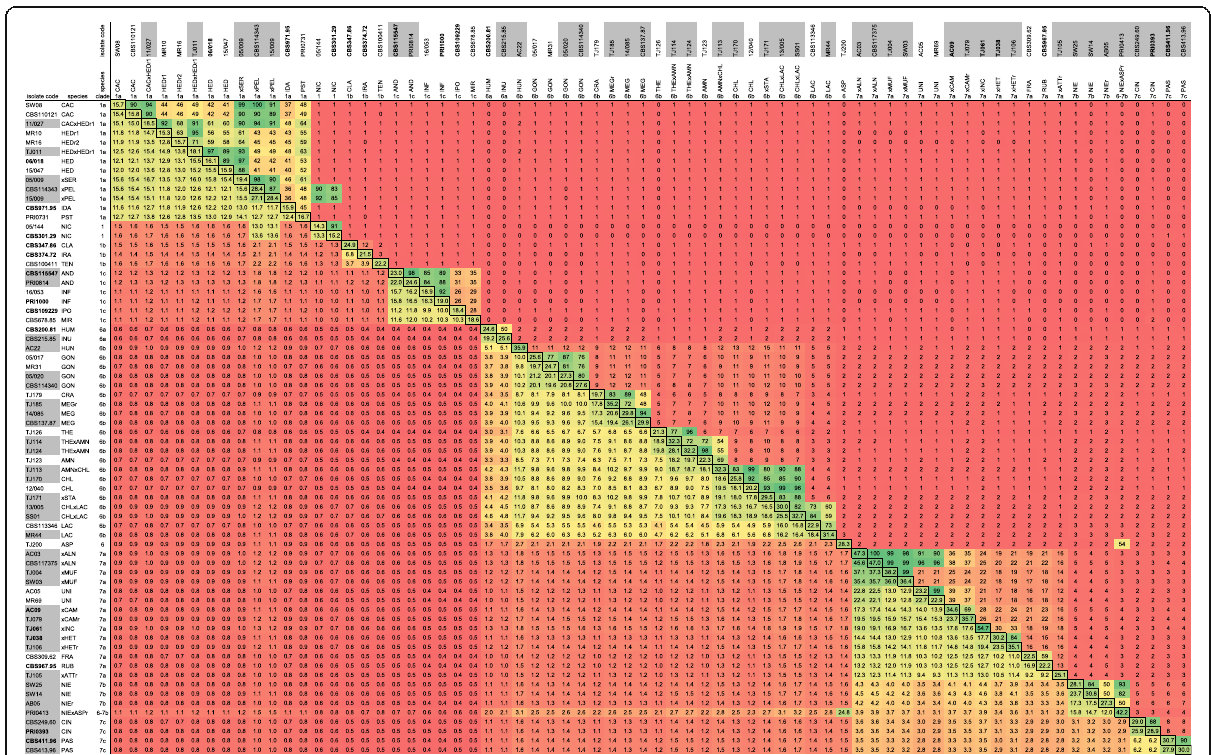
Fig. 2 Pairwise comparison of GBS loci of a selection of isolates from Phytophthora clades 1, 6 and 7. Isolate codes in bold are ex-type strains or authentic strains (see Supplementary Table 1 for details). Isolate codes marked in grey have been identified as hybrids, either previously or in this study. Numbers in the diagonal (with border) indicate the number of loci of each isolate. Numbers under the diagonal represent the number of loci shared among each pair of isolates (expressed as thousands). The colour code in this part of the table denotes the number of shared loci and has a range from green (highest number= 47,273 loci for P. ×alni isolate AC03), to yellow (5000 shared loci) and to red (lowest number = 357 loci shared between P. humicola isolate CBS200.81 and P. ipomoeae isolate CBS109229). Numbers above the diagonal represent the allele similarity (percentage of the shared loci in which at least one allele is identical) of the shared loci (expressed as a percentage). The colour code in this part of the table ranges from green (100%), to yellow (50%) and red (0%). Table S4 contains these data for all isolates in this